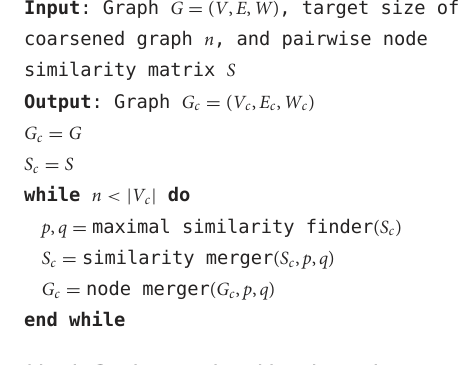
Algorithm 1. Graph coarsening with node